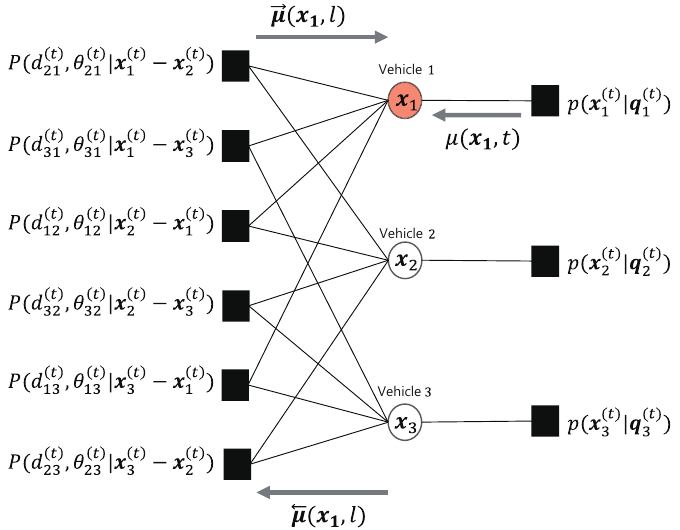
Figure 3. Graphical model associated with example in Figure